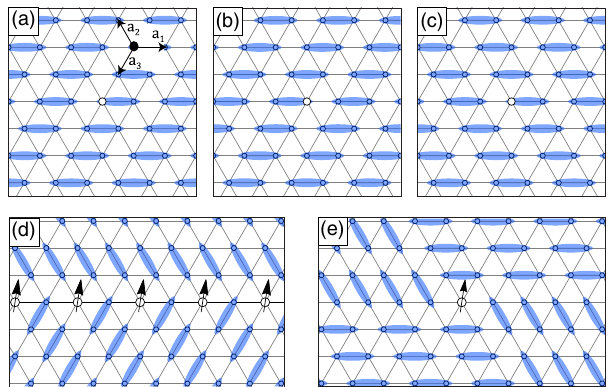
FIG. 3. Triangular lattice columnar VBS order and its topo- logical defects. (a) – (c) Frustration from the triangular lattice endows the columnar VBS order with twofold chirality as well as sixfold orientation: the 12 domains are given by 2 π = 6 rotations of (a) [note common origin in (b)] as well as its opposite-chirality partner (c). (d) Superdomain walls (black lines) between domains of different sets necessarily host spin- 1 = 2 chains when their path takes any orientation except for a single defect-free orientation. In particular, this implies that coarse-grained superdomain walls host broken-up spin chains. (e) Within a given superdomain, topological defects similar to square lattice Z 4 vortices can